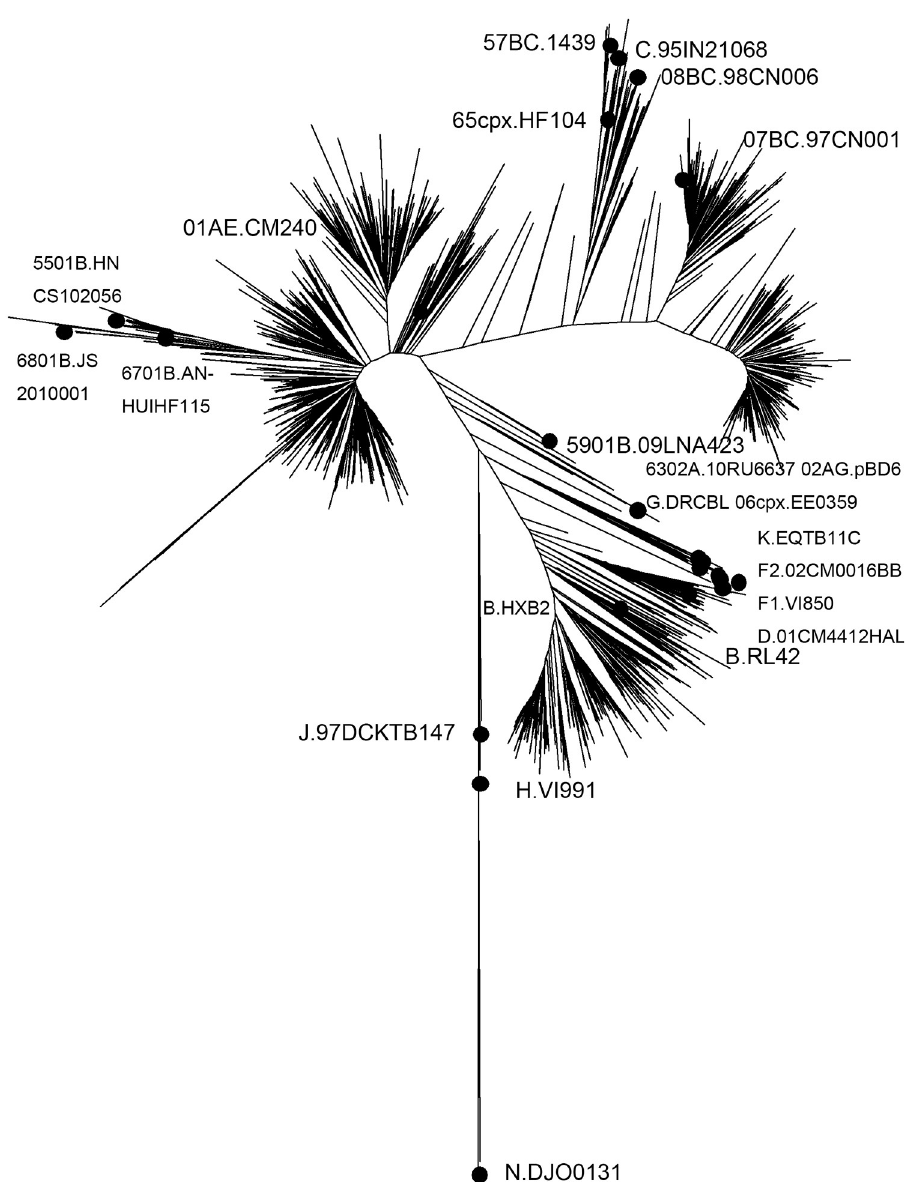
Fig 1. Phylogenetic analysis of pol sequences. Phylogenetic tree was constructed using neighbor-joining methods (Mega 6.0). The black solid squares indicate reference sequences from the Los Alamos HIV sequence database.